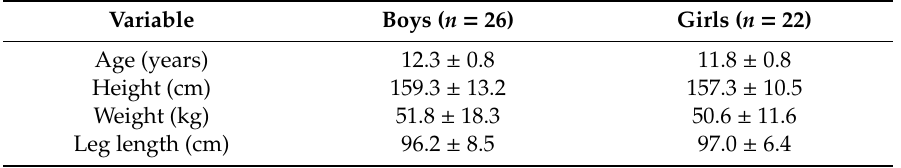
Table 1. Descriptive